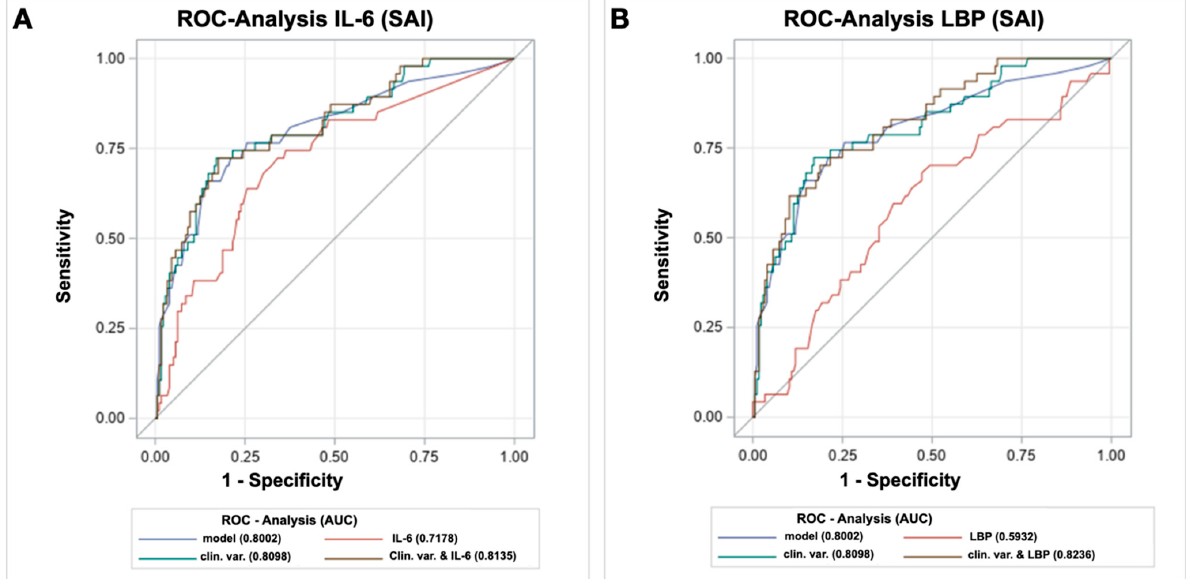
Figure 2. Receiver operating characteristics (ROC)-curves of the baseline biomarkers and the clinical variables in predicting SAIs. ( A ): IL-6; ( B ): LBP. AUC, area under the curve; IL, Interleukin; LBP, lipopolysaccharide binding protein; ROC, Receiver Operating Characteristics; SAI, Stroke-associated infection. Clinical variables comprised the National Institutes of Health Stroke Scale (NIHSS), dysphagia, reduced consciousness and